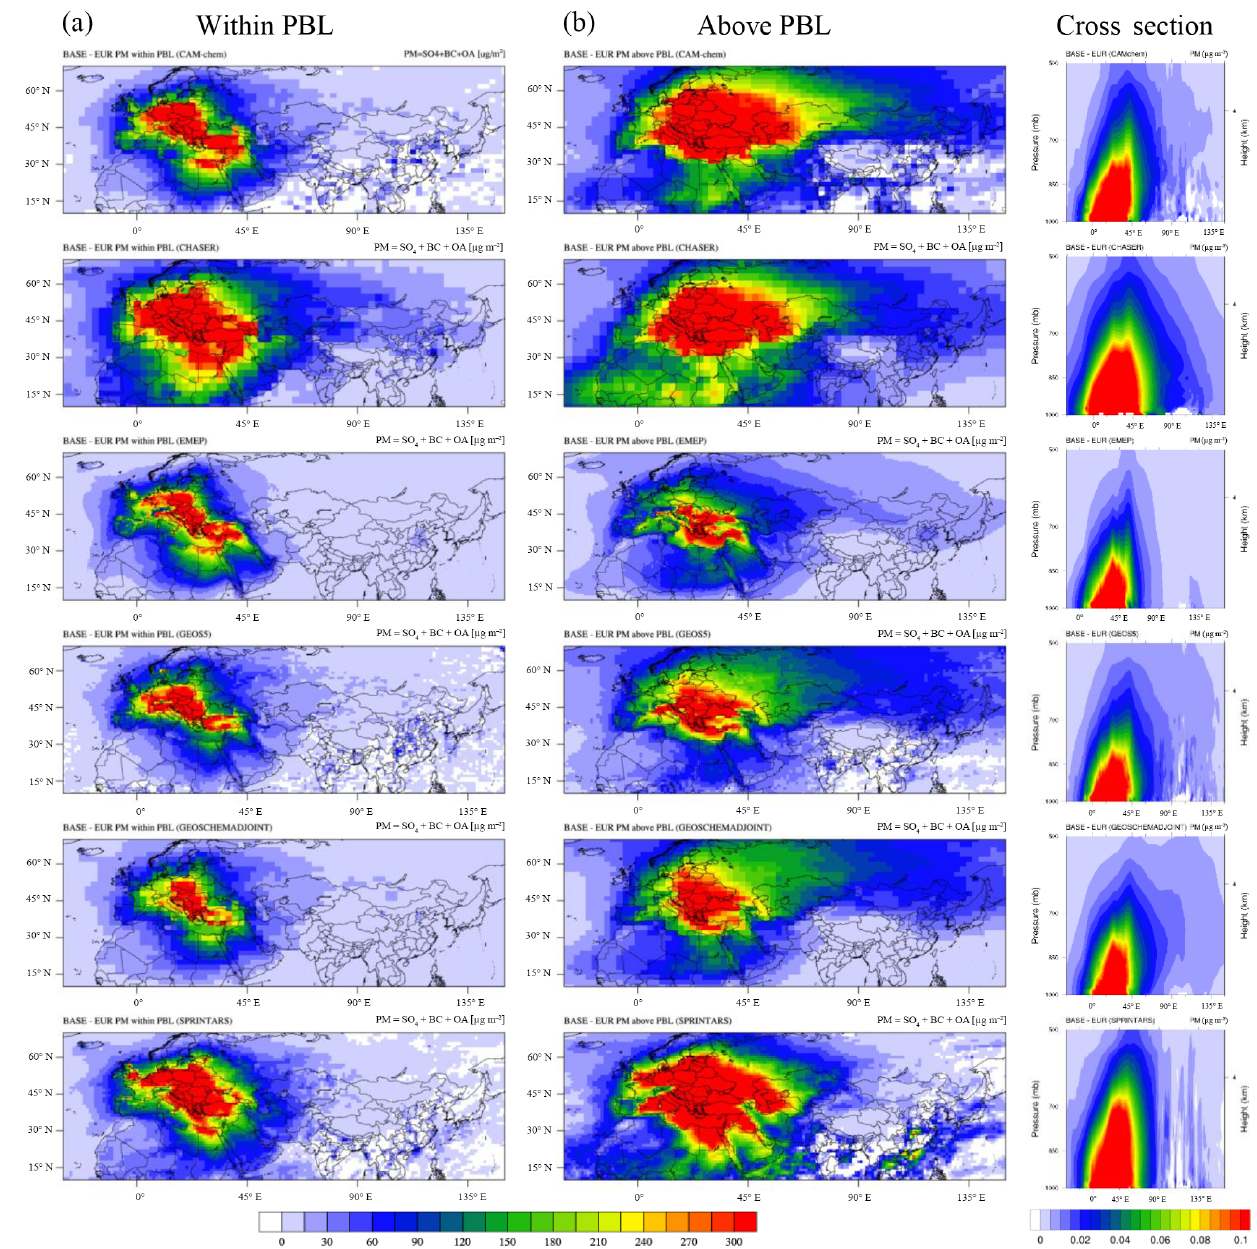
+ (cid:49) OA) under the EURALL scenario 4